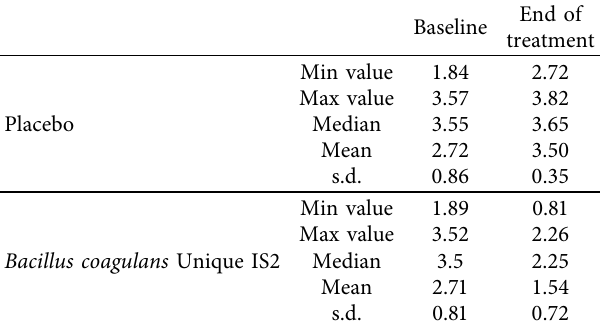
Table 5: Plaque lactobacillus scores at baseline and EOT.